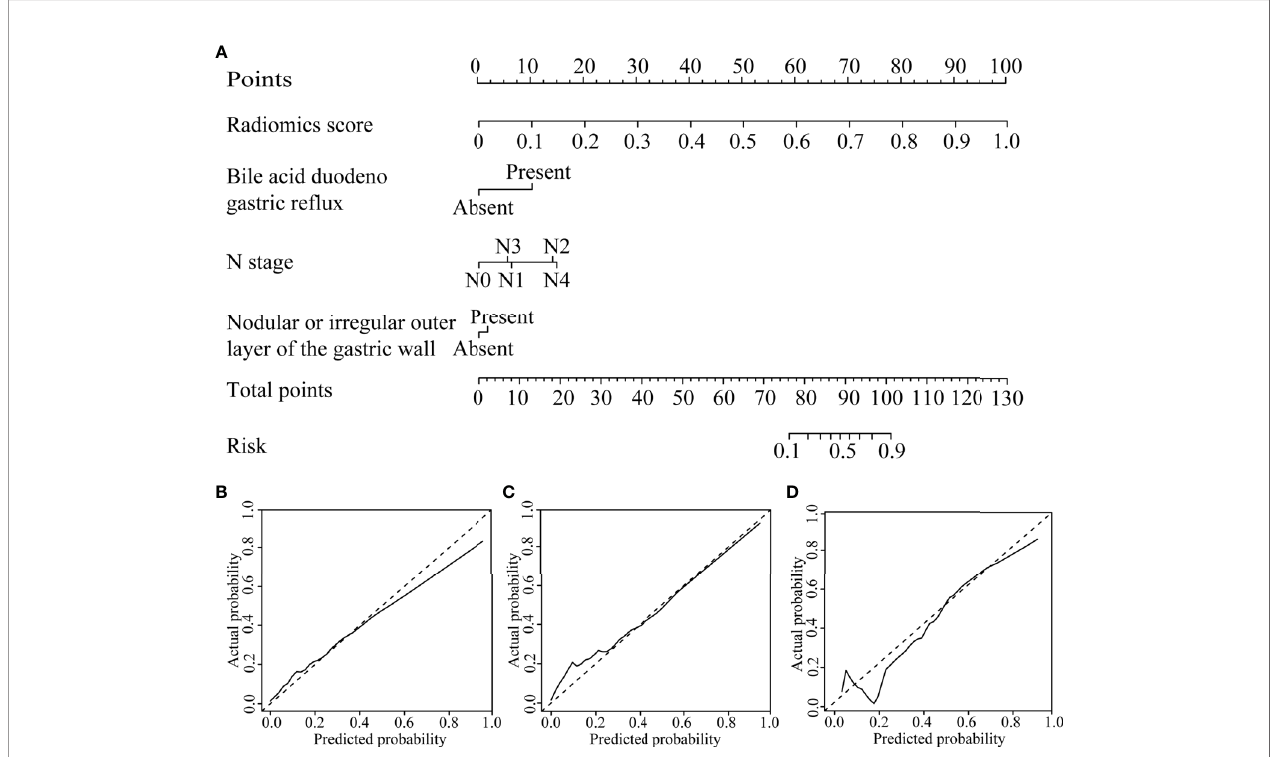
FIGURE 3 | CT-based radiomics nomogram. (A) The radiomics nomogram was developed based on the R-score and the representative clinical risk factors. (B – D) Calibration curves of the nomogram in the training, internal validation and external validation cohorts,